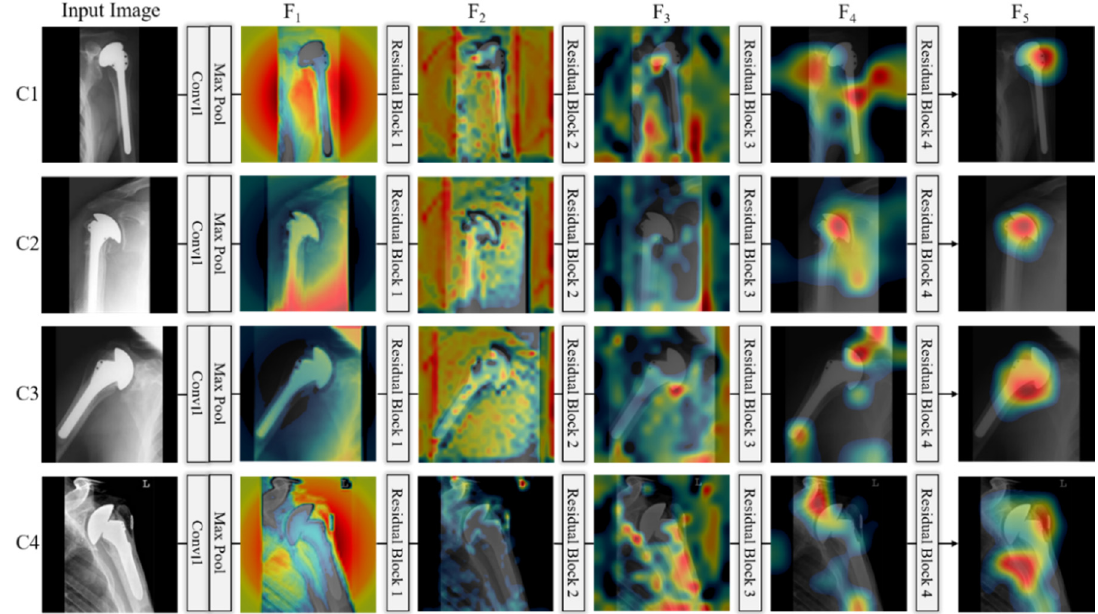
Figure 14. Class activation maps for given inputs of four classes (C1–C4), which are extracted from modified ResNet-50 of Table 2. C1–C4 indicate the classes of the four manufacturers, Cofield, Depuy, Tornier, and Zimmer, respectively.